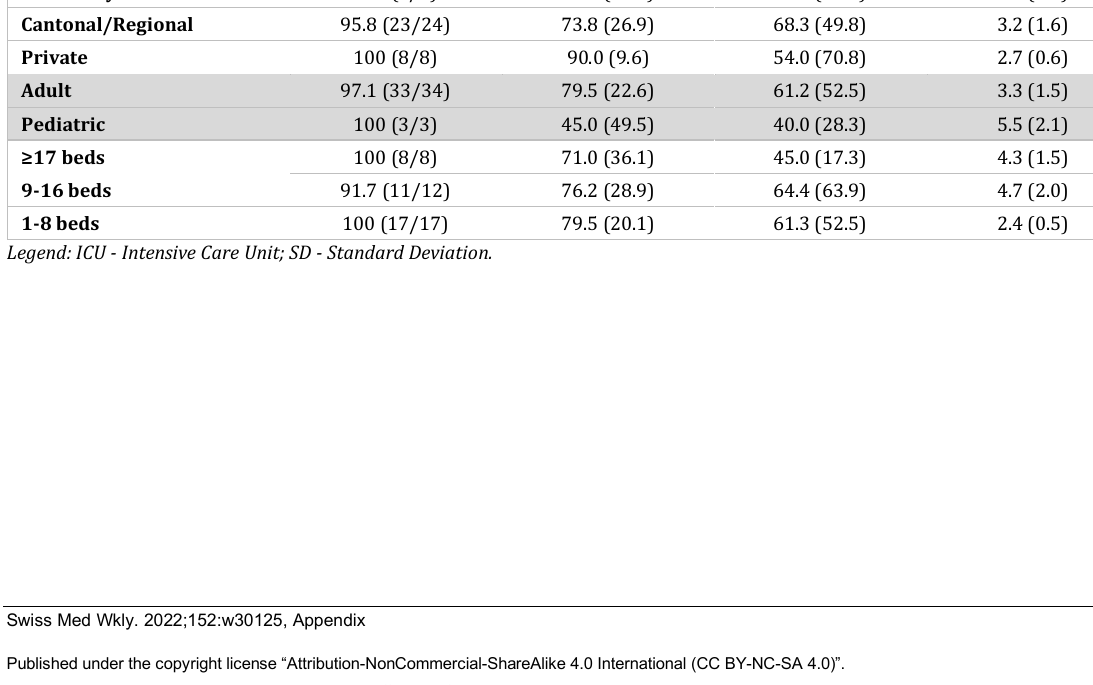
Average number of days in which the measure is provided (days (SD))